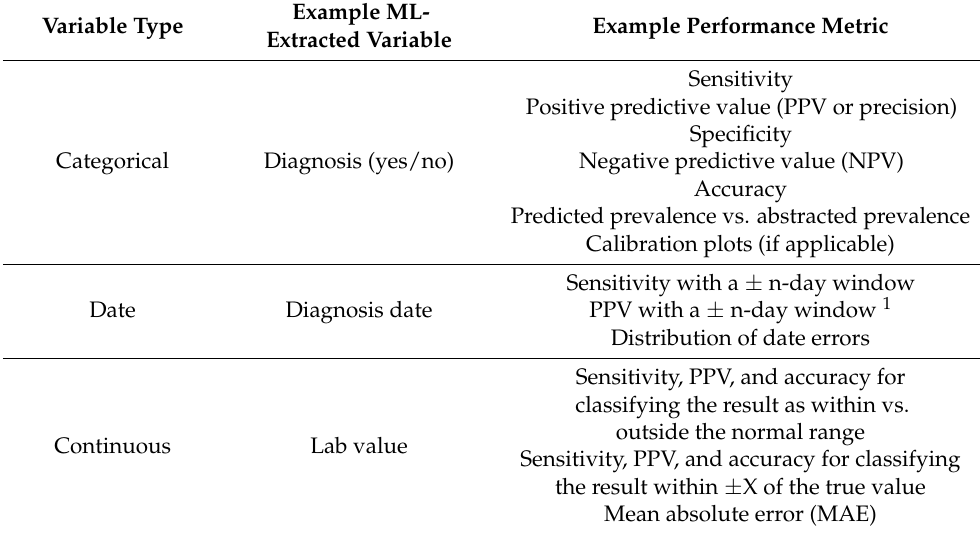
Table 1. Example performance metrics.